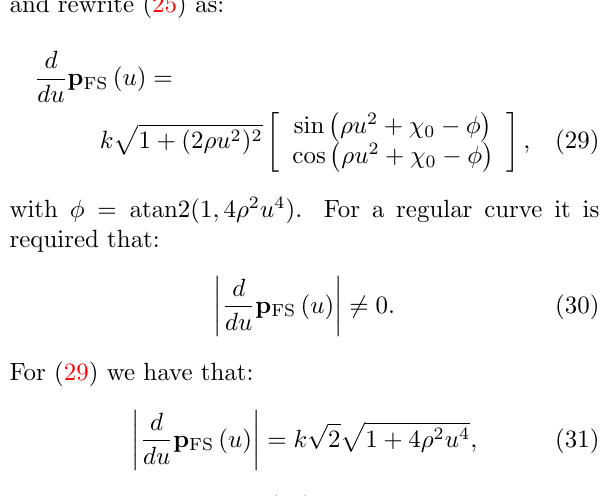
Figure 11: Illustration of the two different parametriza- tions. The geometry of the curve remains